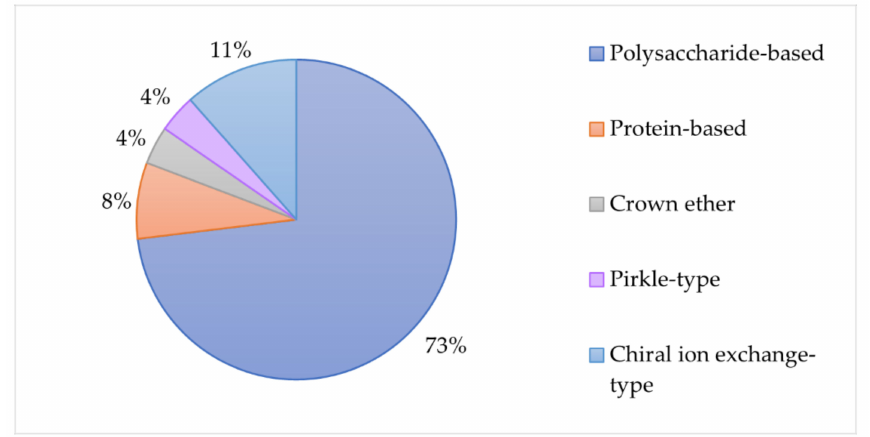
Figure 20. Types of CSPs used for the enantiomeric resolution of